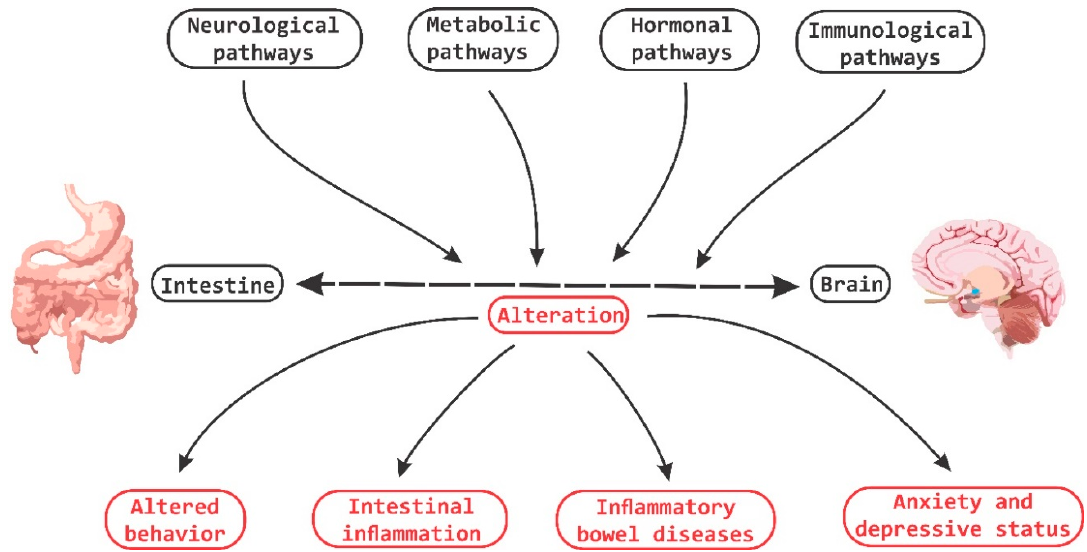
Figure 4. Brain-Gut Homeostasis. The relationship between the intestine and the brain involves signaling pathways at a neural, metabolic, hormonal and immune system levels. The alteration in these pathways is capable of causing changes in cognitive and behavioral processes, as well as inducing inflammatory processes at the periphery level.